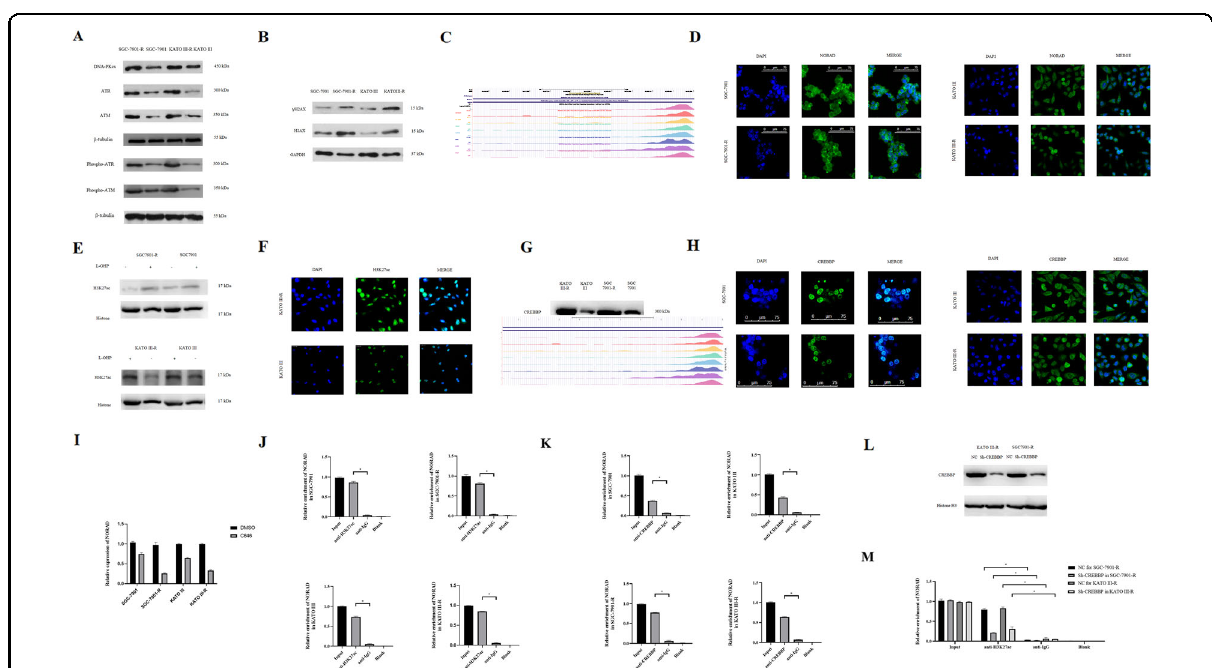
Fig. 4 NORAD was associated with DNA damage repiar response and induced by H3K27ac. A , B Western blot to test the DNA damage repair related genes expression in SGC-7901 and KATO III: DNA-PKcs 450kDa, ATR 300kDa, Phospho-ATR (Ser428) 300kDa, ATM 350kDA, Phospho-ATM (Ser1981) 350kDa, H2AX 15kDa, Phospho-Histone H2AX (Ser139) 15kDa, β -Tubulin 55kDa, GAPDH 37kDa. C UCSC genome browser prediction about the enrichment of H3K27ac at the promoter region of NORAD in different cell lines. D NORAD location in SGC-7901, SGC-7901-R, KATO III, and KATO III-R by FISH tests. E H3K27ac expression in SGC-7901, SGC-7901-R, KATO III, and KATO III-R by western blot: H3K27ac 17kDa, Histone H3 17kDa. F H3K27ac location in SGC-7901, SGC-7901-R, KATO III, and KATO III-R by FISH tests. G CREBBP expression in SGC-7901, SGC-7901-R, KATO III, and KATO III-R by western blot: CREBBP 300kDa, β -Actin 45kDa. H CREBBP location in SGC-7901, SGC-7901-R, KATO III, and KATO III-R by FISH tests. I C646 can decrease the expression of NORAD in SGC-7901, SGC-7901-R, KATO III, and KATO III-R (SGC-7901, t = 11.52, P = 0.000; SGC-7901-R, t = 18.28, P = 0.000; KATO III, t = 17.64, P = 0.000, KATO III-R, t = 33.85, P = 0.000). J ChIP results to test the enrichment of H3K27ac at the promoter region of NORAD in SGC-7901, SGC-7901-R, KATO III, and KATO III-R. anti-H3k27ac vs anti IgG: SGC-7901, t = 17.19, P = 0.000; SGC-7901-R, t = 21.03, P = 0.000; KATO III, t = 31.22, P = 0.000, KATO III-R, t = 20.82, P = 0.000. K ChIP results to test the enrichment of CREBBP at the promoter region of NORAD in SGC-7901, SGC-7901-R, KATO III, and KATO III-R. anti-H3k27ac vs anti IgG: SGC-7901, t = 9.83, P = 0.000; SGC-7901-R, t = 15.83, P = 0.000; KATO III, t = 7.99, P = 0.000, KATO III-R, t = 19.92, P = 0.000. L Downregulation of CREBBP in SGC-7901-R and KATO III-R: CREBBP 300kDa, β -Tubulin 55kDa. M CREBBP knockdown can inhibit the enrichment of H3K27ac at the promoter region of NORAD in SGC-7901-R and KATO III-R. anti-H3k27ac: SGC-7901 vs SGC-7901-R, t = 16.23, P = 0.000; KATO III vs KATO III-R, t = 13.79, P =